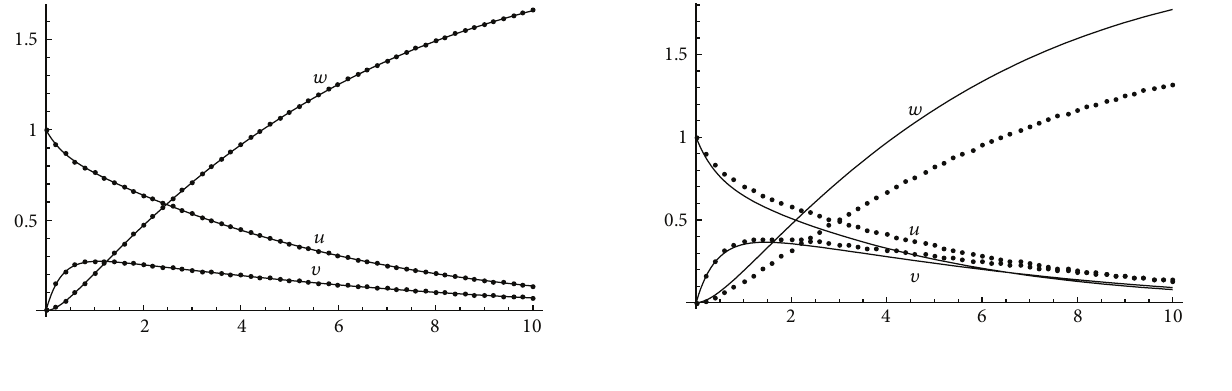
Figure 2: Profile of the normalized concentrations of the substrate 𝑢 , enzyme-substrate complex 𝑣 , and product 𝑤 for 𝑘 = 𝛼 = 𝛼 = 1 . MSDTM solution (solid line); Runge- 𝜀 = 0.5 , and 𝛼 1 2 3 Kutta method solution (dotted line).